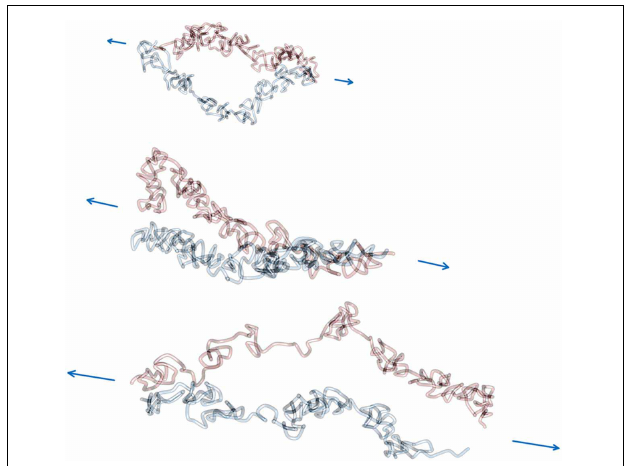
FIGURE 6 | Force extension of non-interlinked model sister chromatids. Model chromatids are permanently linked together at the ends of the chromosome. The linking probability for interlinks is set to 0, which means that there are no interlinks between model sister chromatids. Therefore, segments of both fibers are not in close proximity along the contour and also not necessarily aligned even at higher pulling forces. The force was applied via a pulling potential U pull that is proportional to the end-to-end distance of each model sister chromatid and the given applied force F . In this figure three example conformations at forces 0 . 6 , 1 . 2 and 1 . 8 k b T / l . u . are shown. The figure shows how the pulling force first cause a elongation of the model chromatids and eventually lead to a dissolution of the rod-like shaped structure of each of the two sister chromatids at large pulling forces. Note that in the visualization the chain ends where the chromatids were linked to each other are not shown.